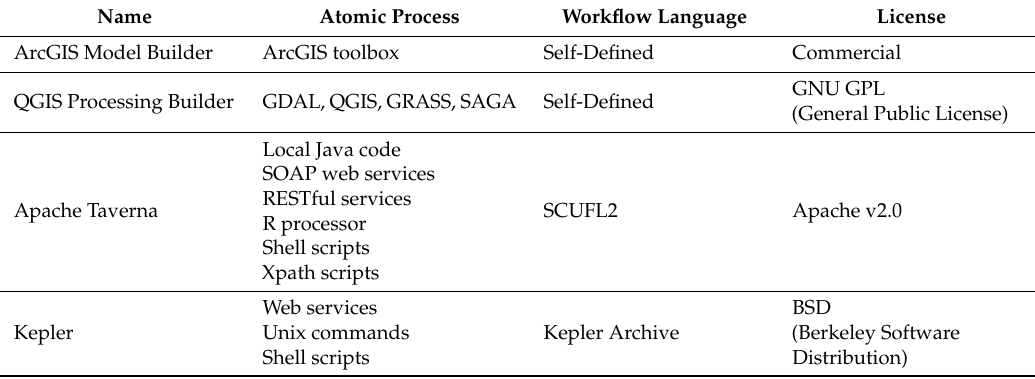
Table 1. Supported atomic processes by existing workflow management software